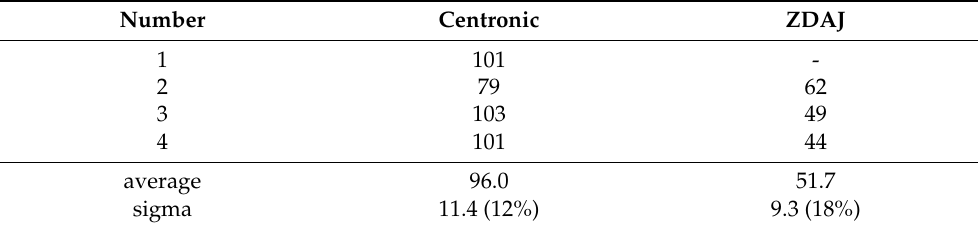
Table 4. The number of neutrons collected by single Centronic and ZDAJ